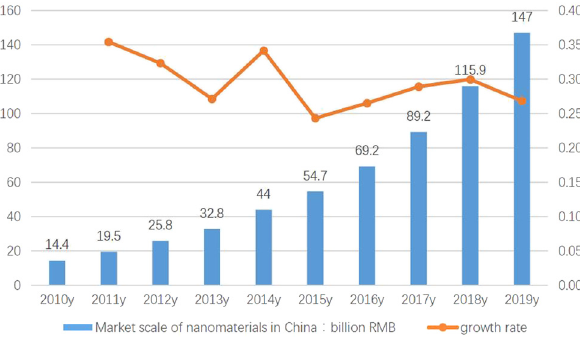
Figure 19: Market scale of nanomaterials in China in 2010 – 2019 [ 165 ] .